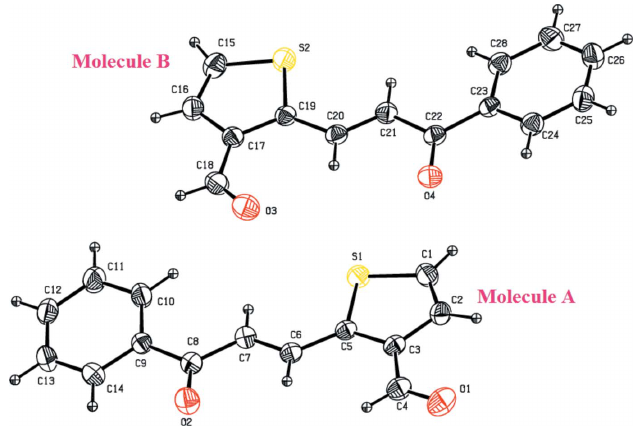
Figure 1 The molecular structure of the title compound, with the atom labelling. Displacement ellipsoids are drawn at the 30% probability